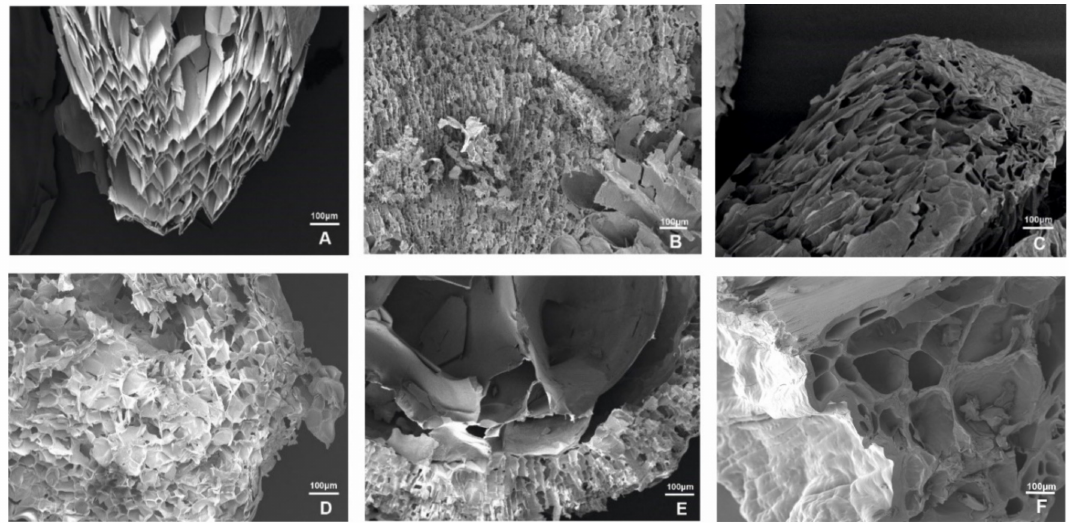
Figure 2. The internal structure of alginate beads stabilized by divalent cations: Ba 2+ ( A ), Mn 2+ ( B ), Ca 2+ ( C ), Zn 2+ ( D ), Cu 2+ ( E ), and Ni 2+ ( F